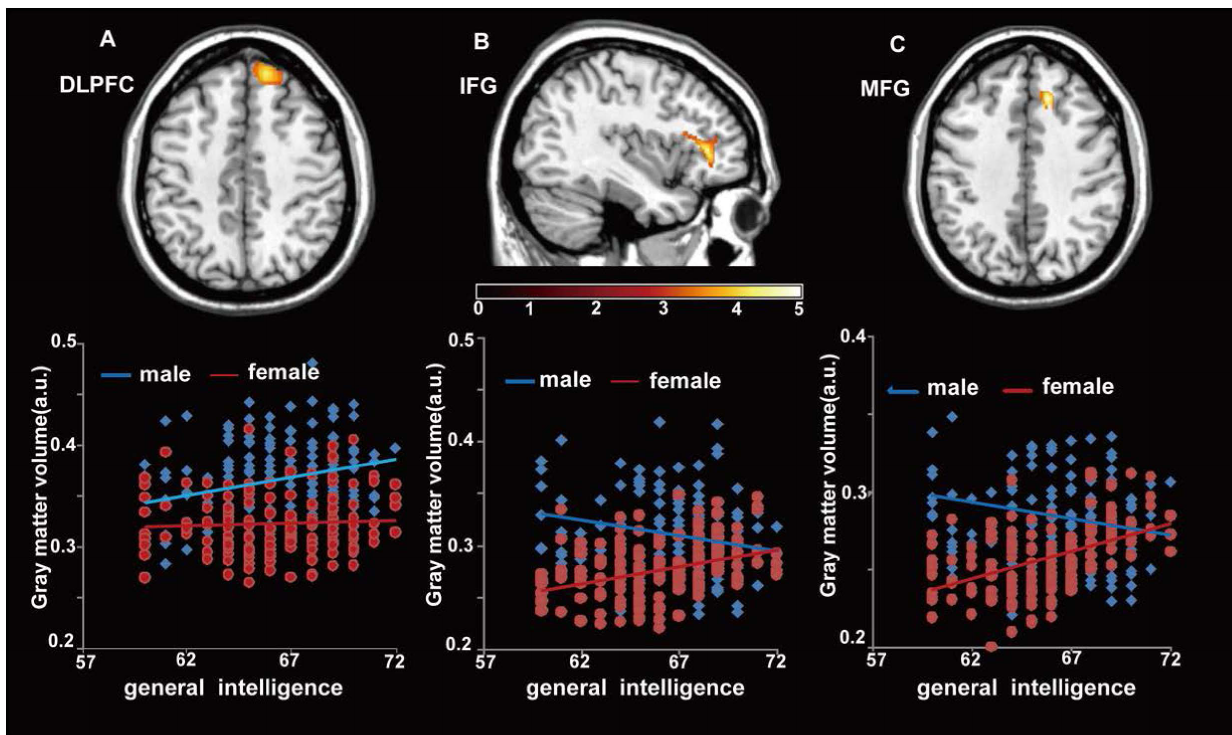
Figure 1. Sex modulates the effect of reasoning ability on gray matter in the Dorsolateral prefrontal cortex (DLPFC), the Medial frontal cortex (MFC), and the Inferior frontal cortex (IFC). The color density represents the T score. The scatter plot between CRT scores and the rGMV is shown for illustration purpose only.